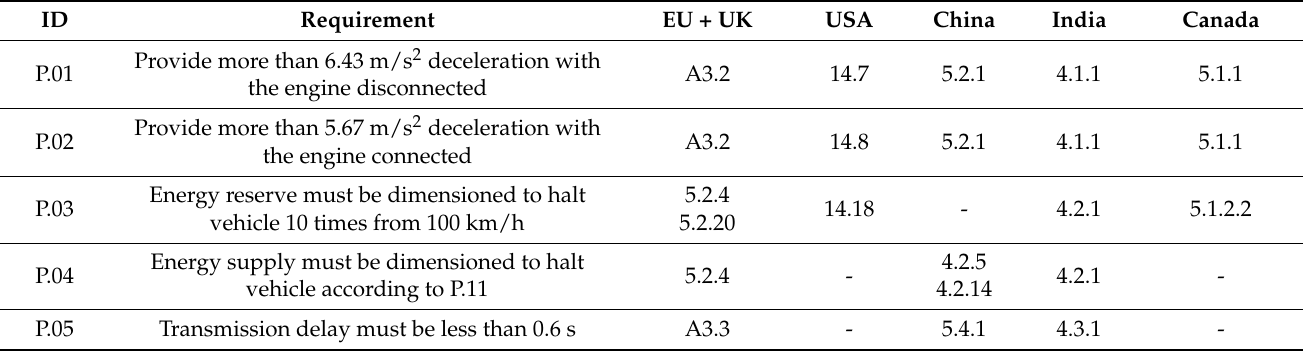
Table 2. Sections of the standard documents related to the performance requirements for intact EMB service braking systems.